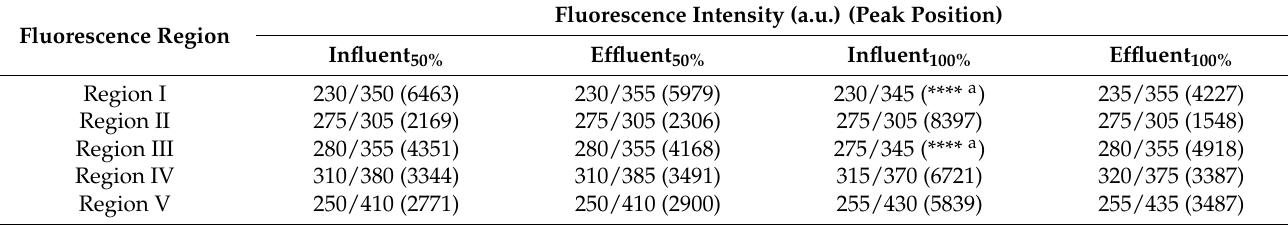
Table 2. Main fluorescence peaks and intensity of the Excitation–emission matrices (EEMs) of the wastewater. Fluorescence Intensity (a.u.) (Peak Position) Fluorescence Region Influent 50% Effluent 50% Influent 100% Effluent 100% Region